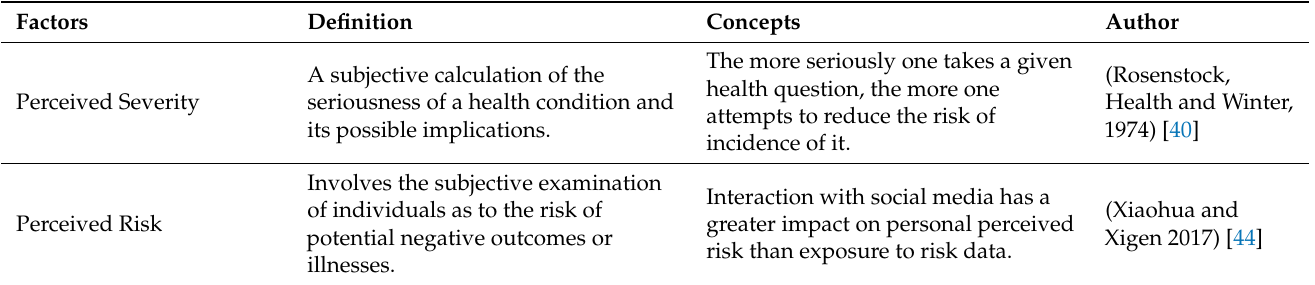
Table 1. Factors affecting Protective Behavior against